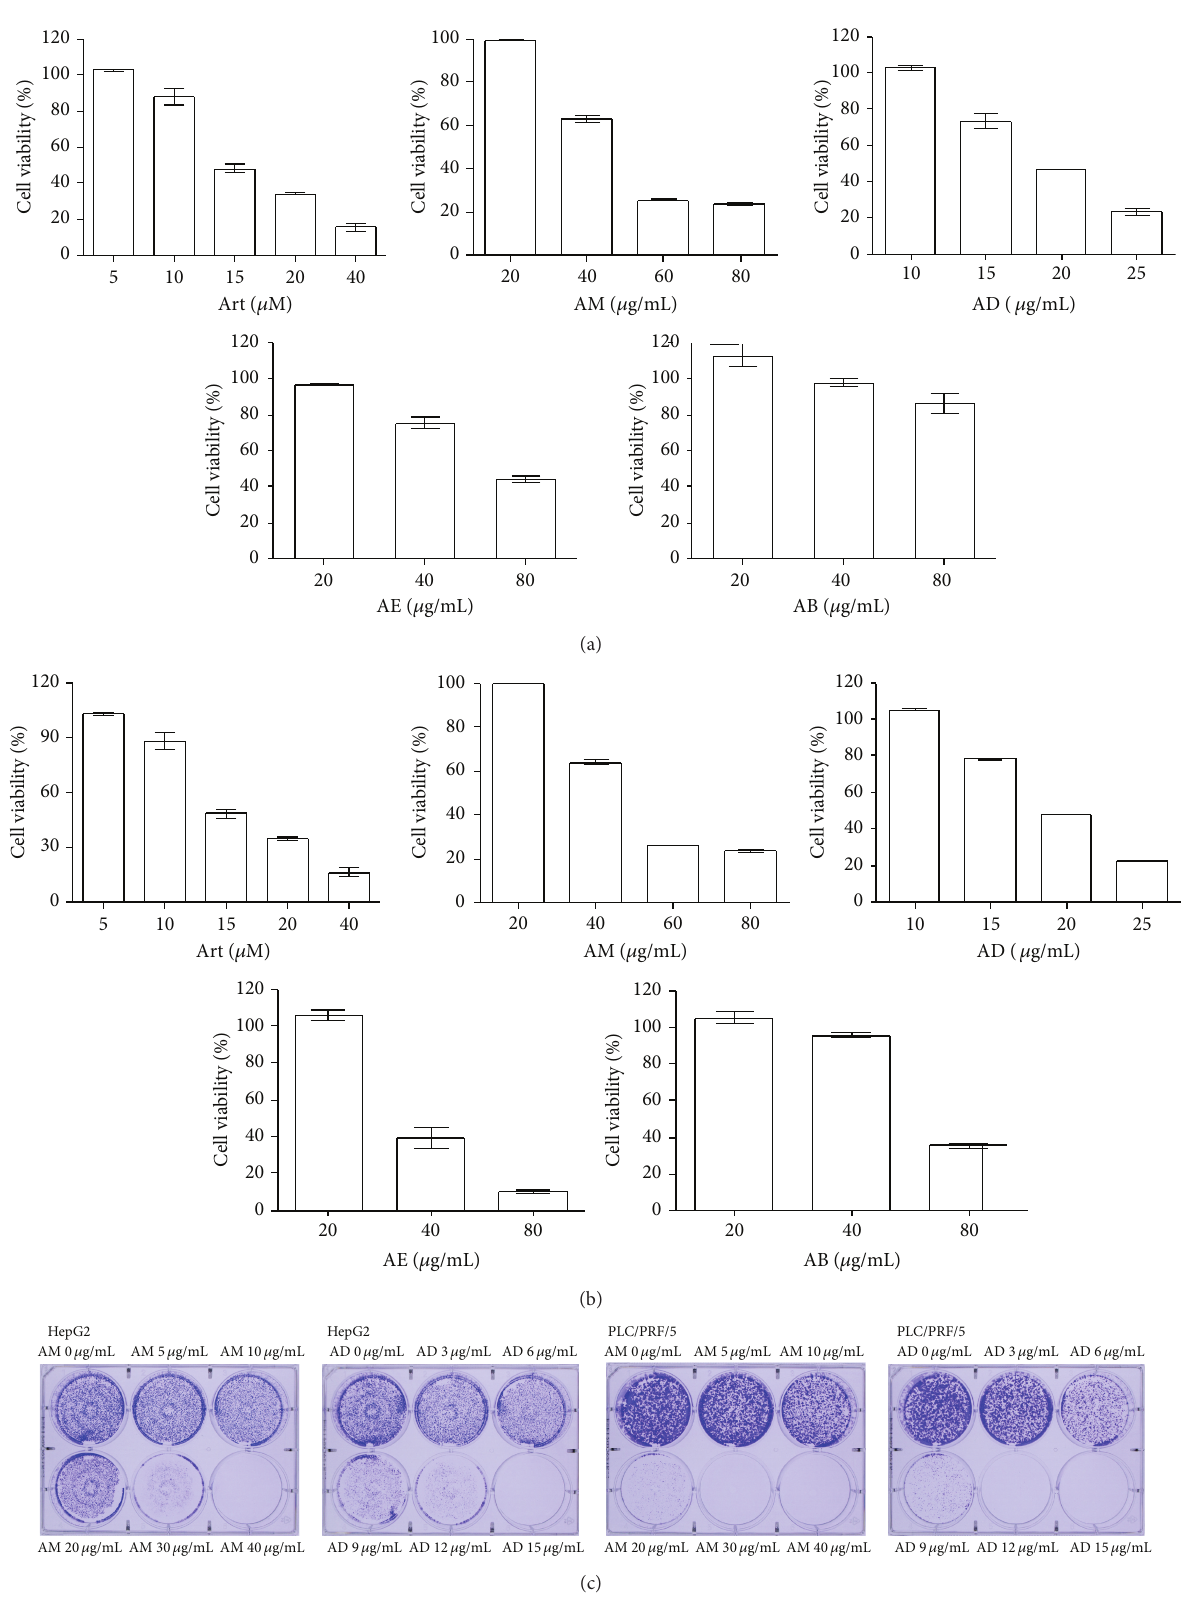
Figure 2: Antihepatoma activity of A. communis fractions toward (a) HepG2 and (b) PLC/PRF/5 hepatoma cells. (c) Long-term cell survival assay of HepG2 and PLC/PRF/5 cells treated with AM and AD for 9 days. Art: artocarpin; AM: methanol extract; AH: n -hexane fraction; AD: dichloromethane fraction; AE: ethyl acetate fraction; AB: n -butanol